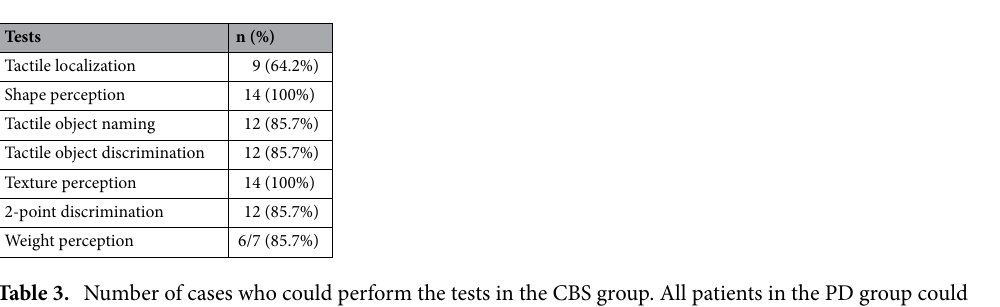
Table 3. Number of cases who could perform the tests in the CBS group. All patients in the PD group could perform all tests.